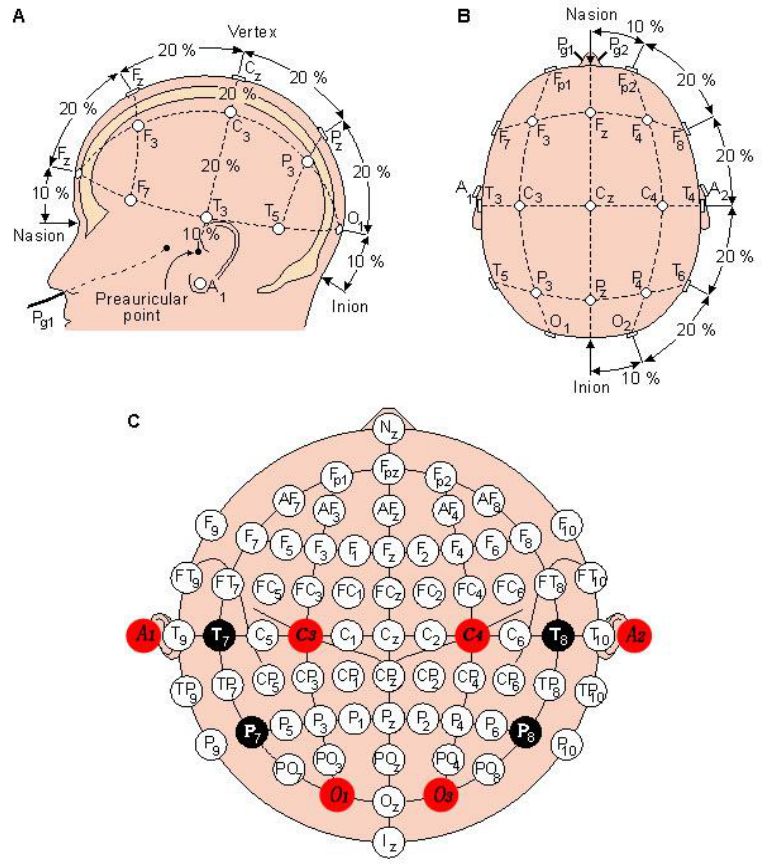
Figure 8. The international 10–20 system of electrode placement